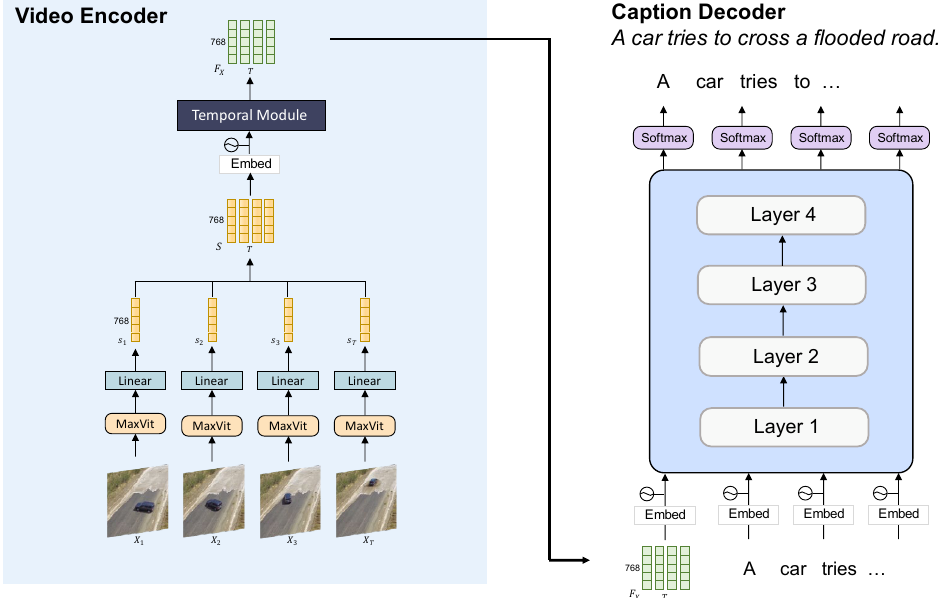
Figure 3. An illustration of the first proposed captioning model. The figure illustrates an example of sampling four frames from a video ( T = 4) and extracting frame-level features from each frame. The frames’ features are concatenated together and passed to an attention module to consider the temporal information.